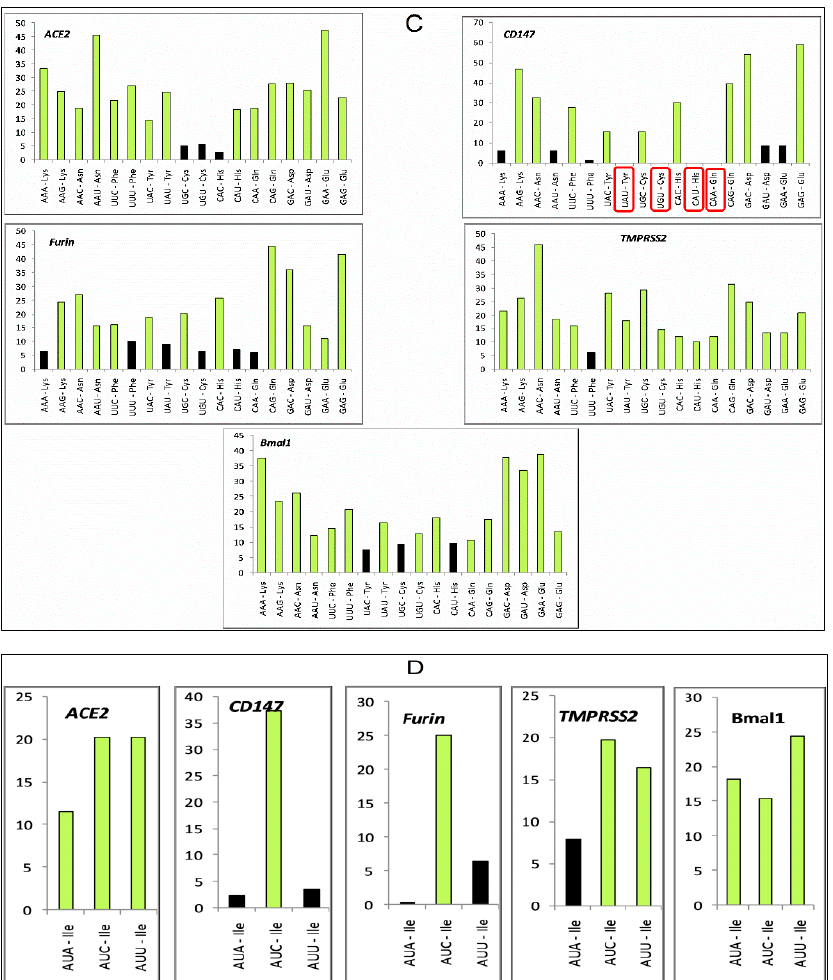
Figure 4. Rare codons in ( A ) Six-fold, ( B ) four-fold, ( C ) two-fold, and ( D ) three-fold degenerate codons in ACE2 , BMAL1 , TMPRSS2 , FURIN , and CD147 genes. Codons less than 10 in number in a standard transcript of 1000 bp (normalized transcript length) were considered rare. Codons that are altogether absent in the transcript of a gene are boxed with red color. 3.5. Codon Context Analysis Revealed Val (GTG) Initiated Codon Pair Abundance in CD147, FURIN, and TMPRSS2